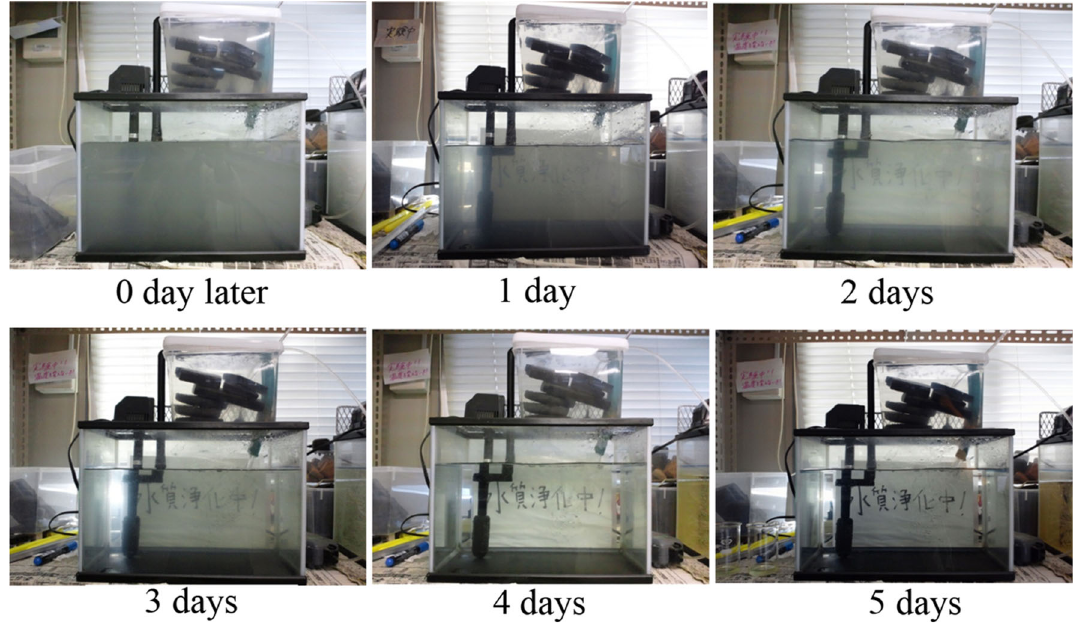
Fig. 2 Change of the transparency of the artificial waste water (15 L) containing 10 mL of milk, 15 mL of AS, and 750 g of